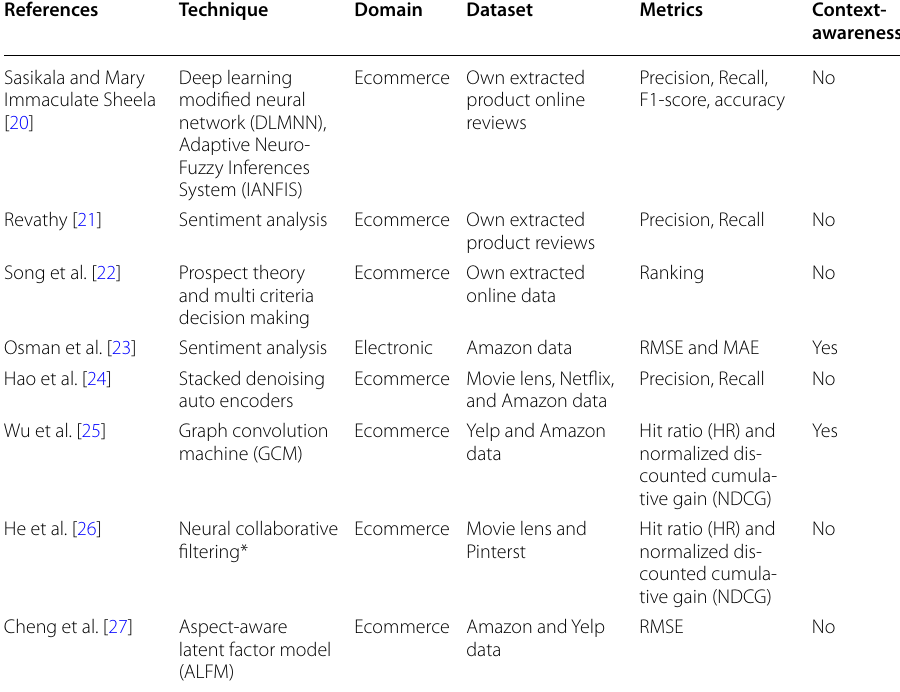
Table 1 Comparative analysis of related